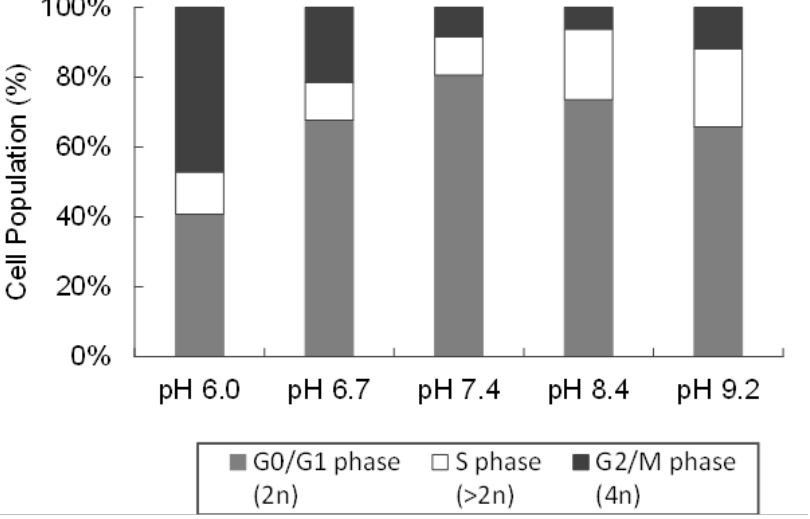
Figure 7. Cell cycle analysis of MDA-MB-231 cells in different pHs of medium. MDA-MB-231 cells were seeded in a 12-well plate and they were incubated at five different pHs of DMEM—pH 6.0, pH 6.7, pH 7.4, pH 8.4, and pH 9.2—for 5 days. The cell cycle (the distribution of cells in the G0/G1, S and G2/M phases) was measured by a flow cytometer after staining the DNA using propidium io- dide.